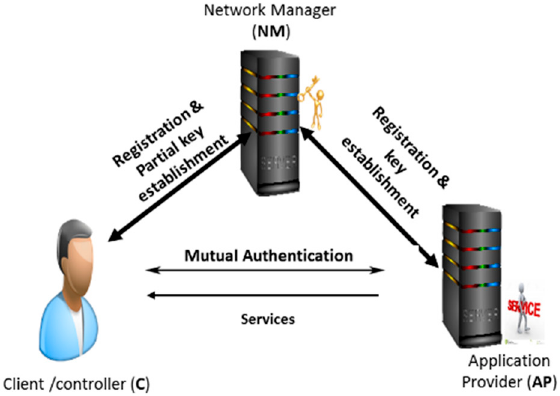
Figure 2. Mutual authentication overview.